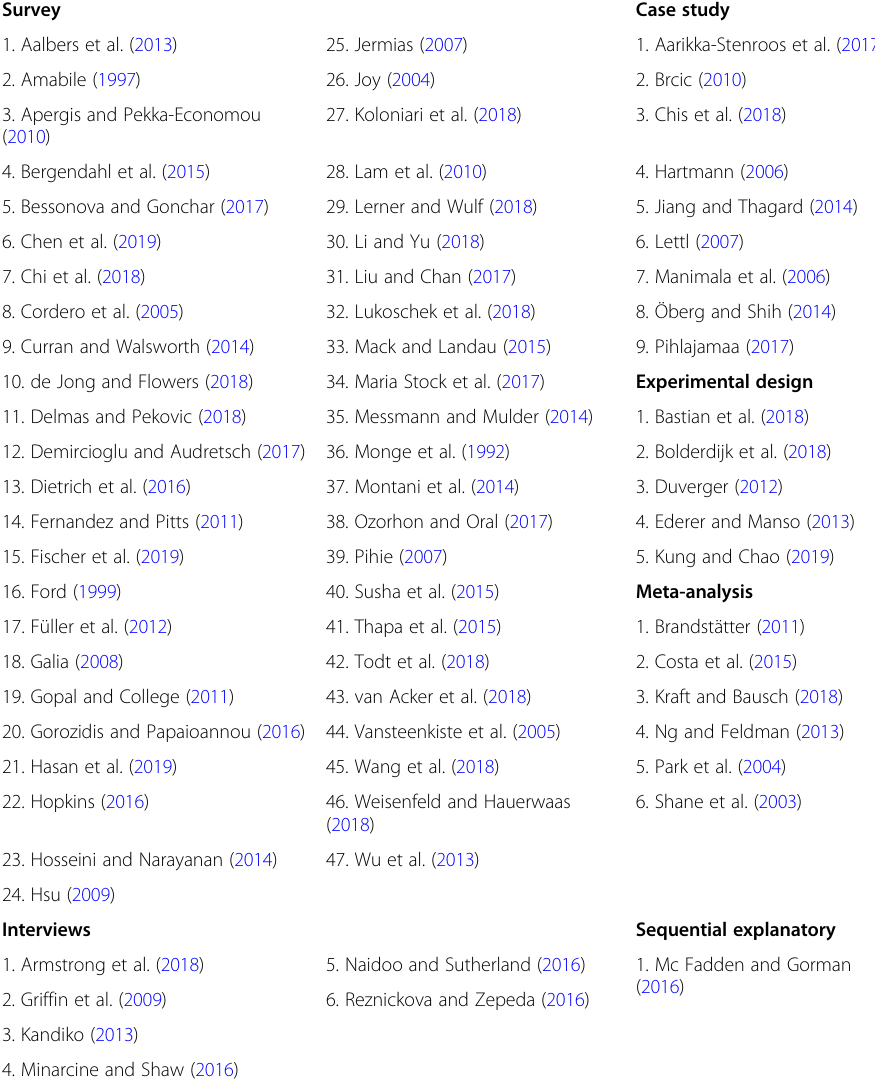
Table 5 Research design groupings of included studies